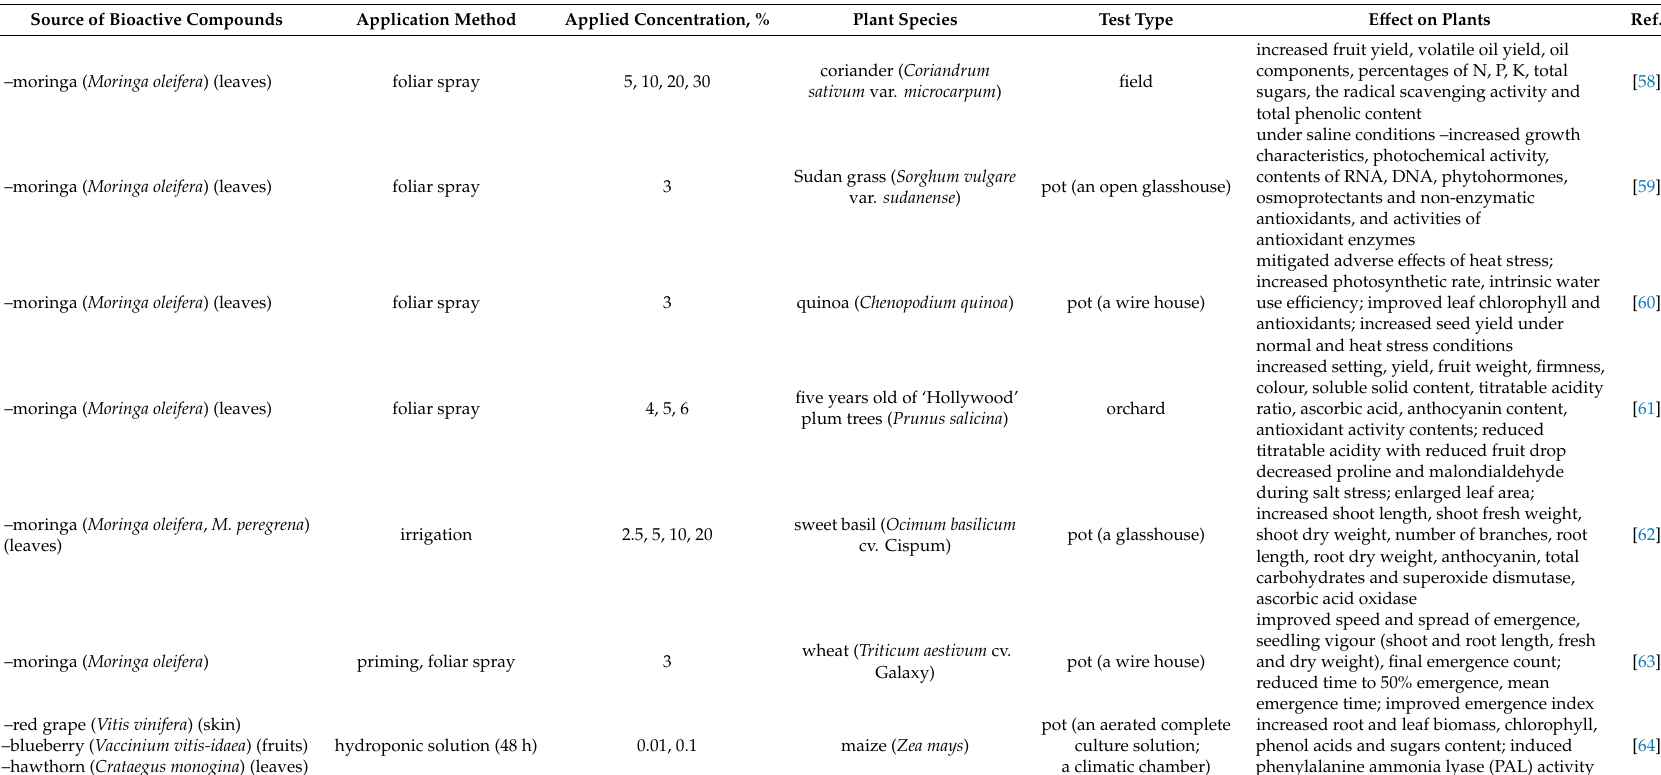
Table 7. Natural raw materials used for biostimulant production and their application in plant